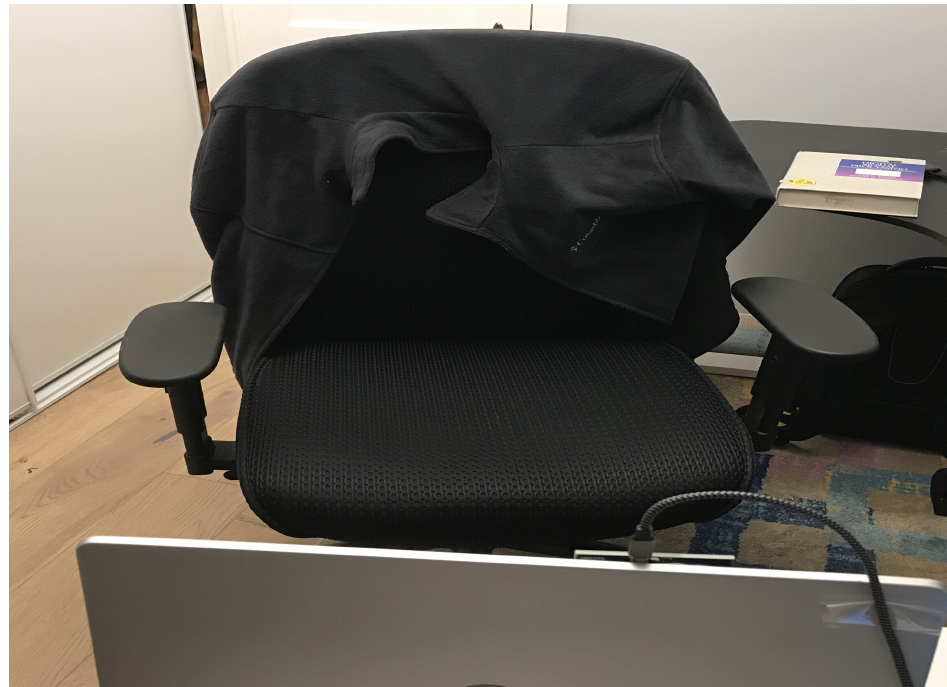
Figure 2. Subject under test will be sitting on this chair infront of the radar and RealSense